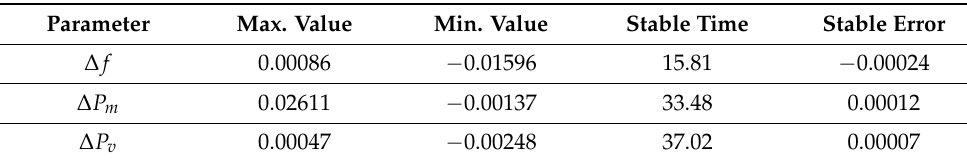
Figure 10. Dynamic response of steam value position using IPSO-BP-PI technique. Table 3. Specific values for random load